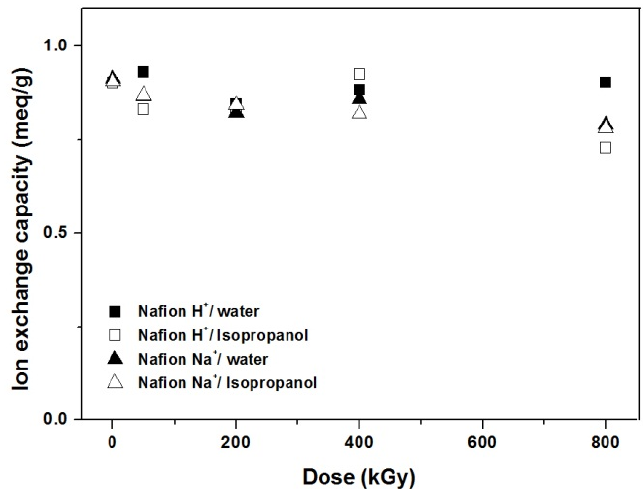
Figure 6. Ion exchange capacity of EB-irradiated Nafion membranes (both acid and sodium forms) in water and